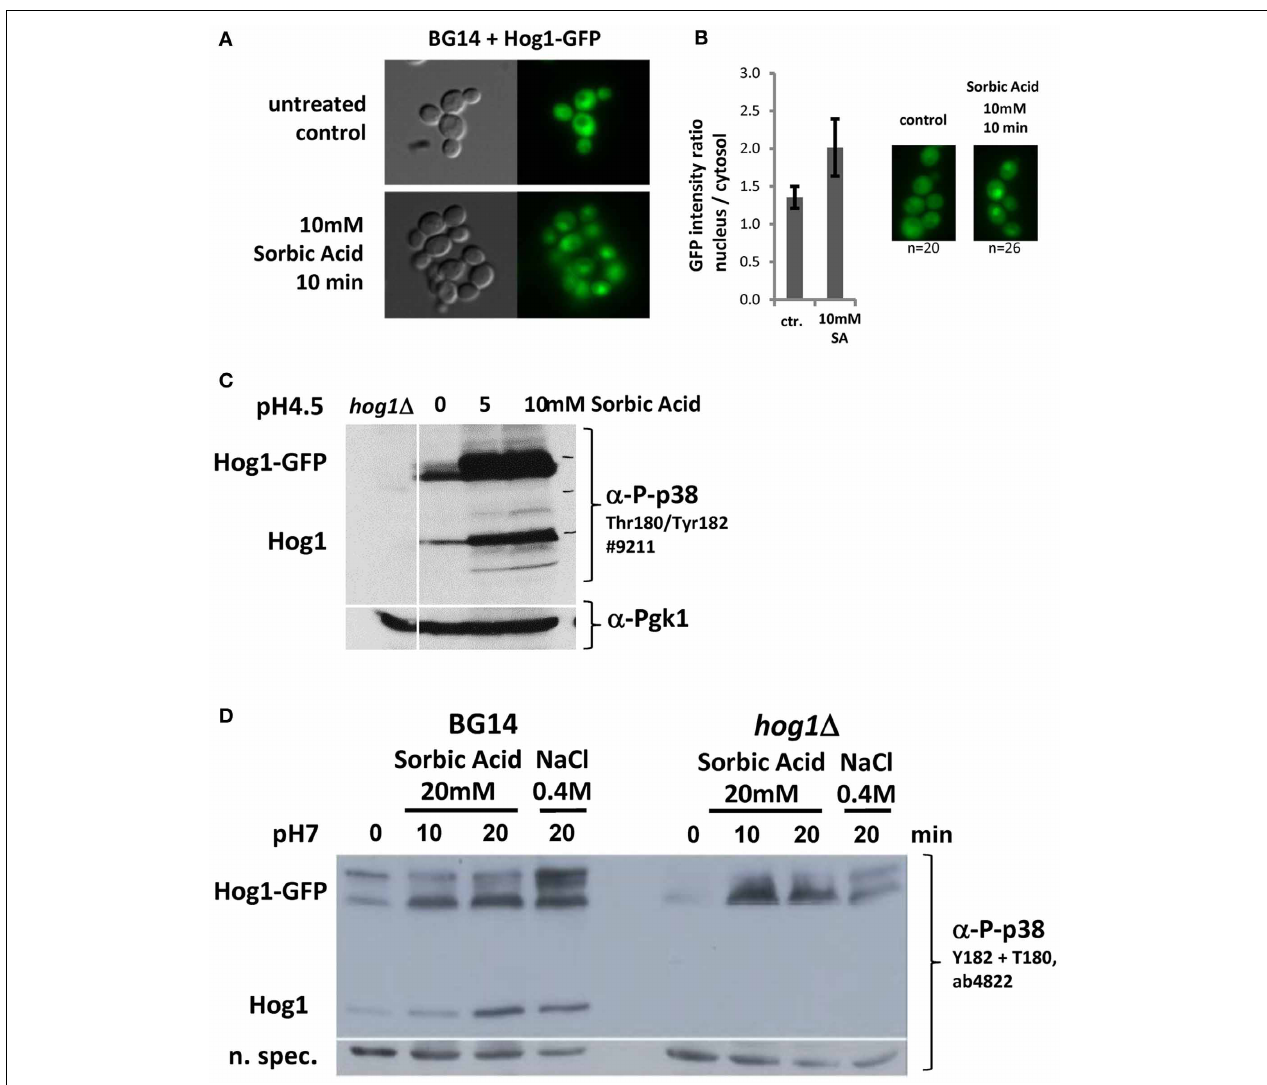
FIGURE 3 | (A) CgHog1 accumulation increases in the nucleus of sorbic acid stressed cells. Life Microscopy of BG14 expressing CgHog1-GFP without stress (upper panel) or under Sorbic acid exposure (10min, 10mM, lower panel). (B) Nuclear accumulation of Hog1 upon stress induction results in a higher fluorescence signal and increases the nucleus to cytosol signal ratio. Fluorescence intensity ratio, nucleus to cytosol, in unstressed ( n = 20) and stressed ( n = 26) cells. (C) CgHog1 and CgHog1-GFP phosphorylation increases in sorbate treated cells. Cultures of BG14, BG14 hog1 (cid:2) , and BG14 carrying pHog1-GFP were grown in YPD (pH 4.5) to the